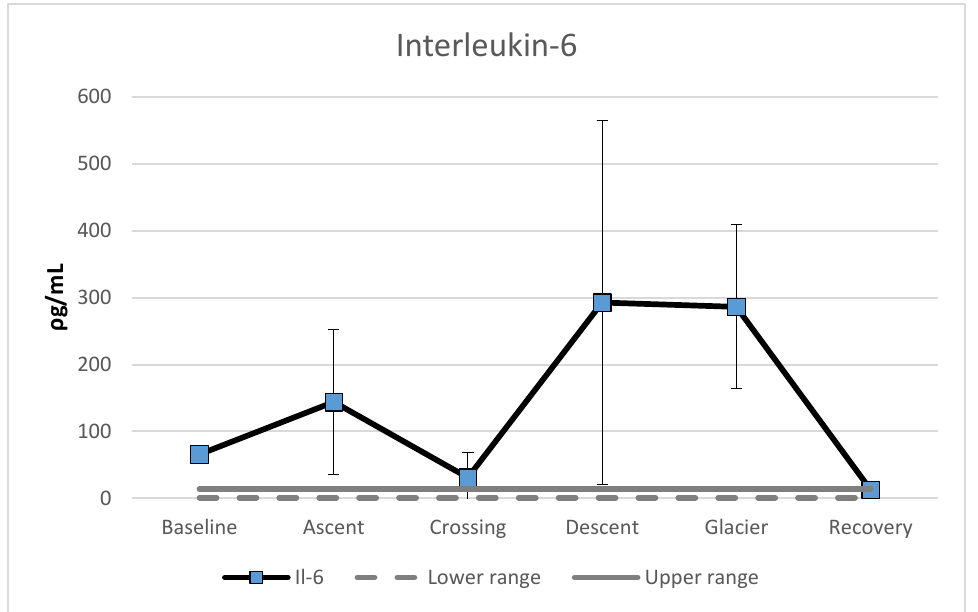
Figure 3. Mean level of Interleukin-6 (ρg/mL), separated for the different phases during the expedition. Error bars represent standard deviations.